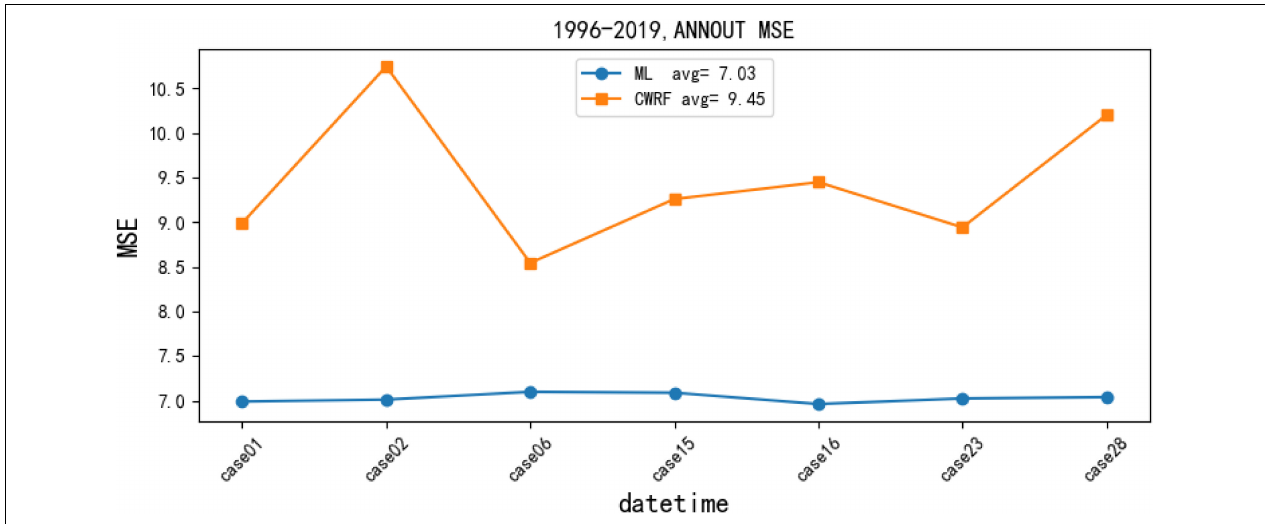
FIGURE 9 | Mean square error (MSE) change graph of precipitation data correction results for 7 cases (i.e., 01, 02, 06, 15, 16, 23, and 28) of CWRF based on the artificial DD model.